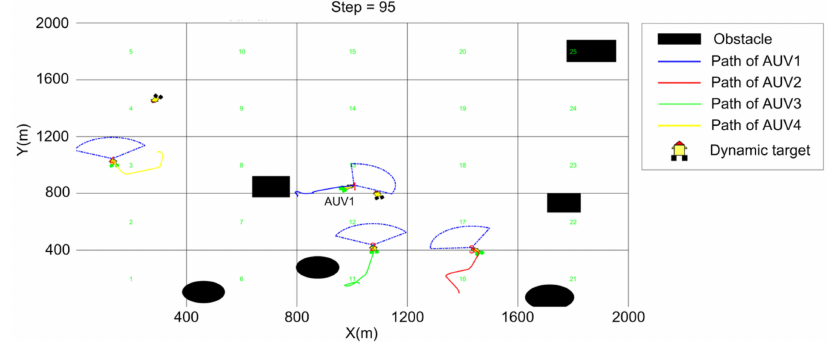
Figure 16. T = 95 (steps).